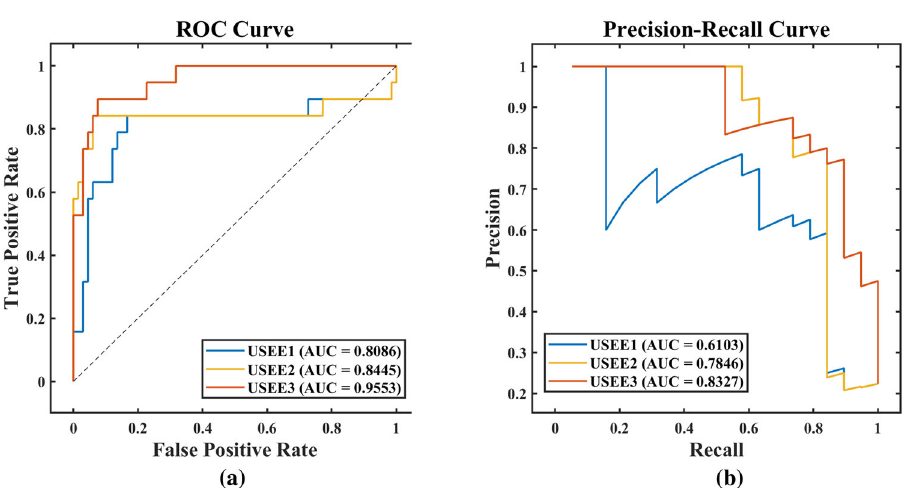
Fig. 2 Comparison of the classi fi cation effects of various data combinations. Only test set results are shown. a ROC Curve, b Precision- Recall Curve.